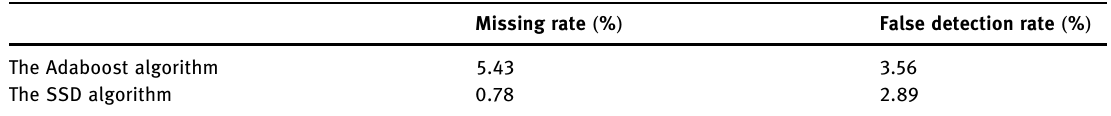
Table 1: Comparison of portrait detection performance